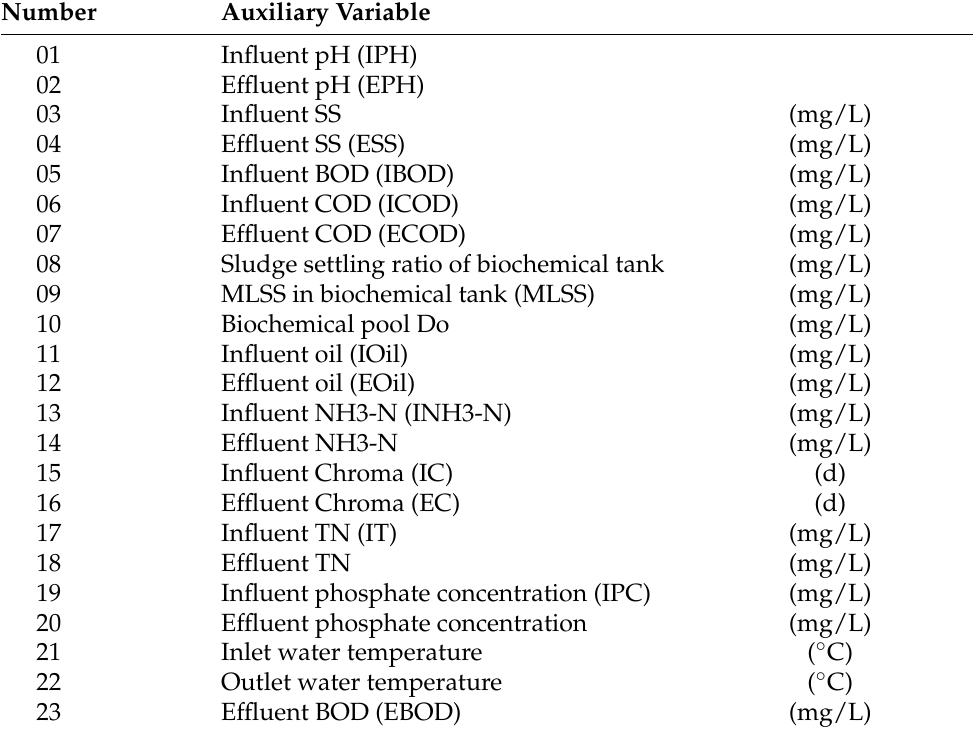
Table 1. Effluent BOD data set.